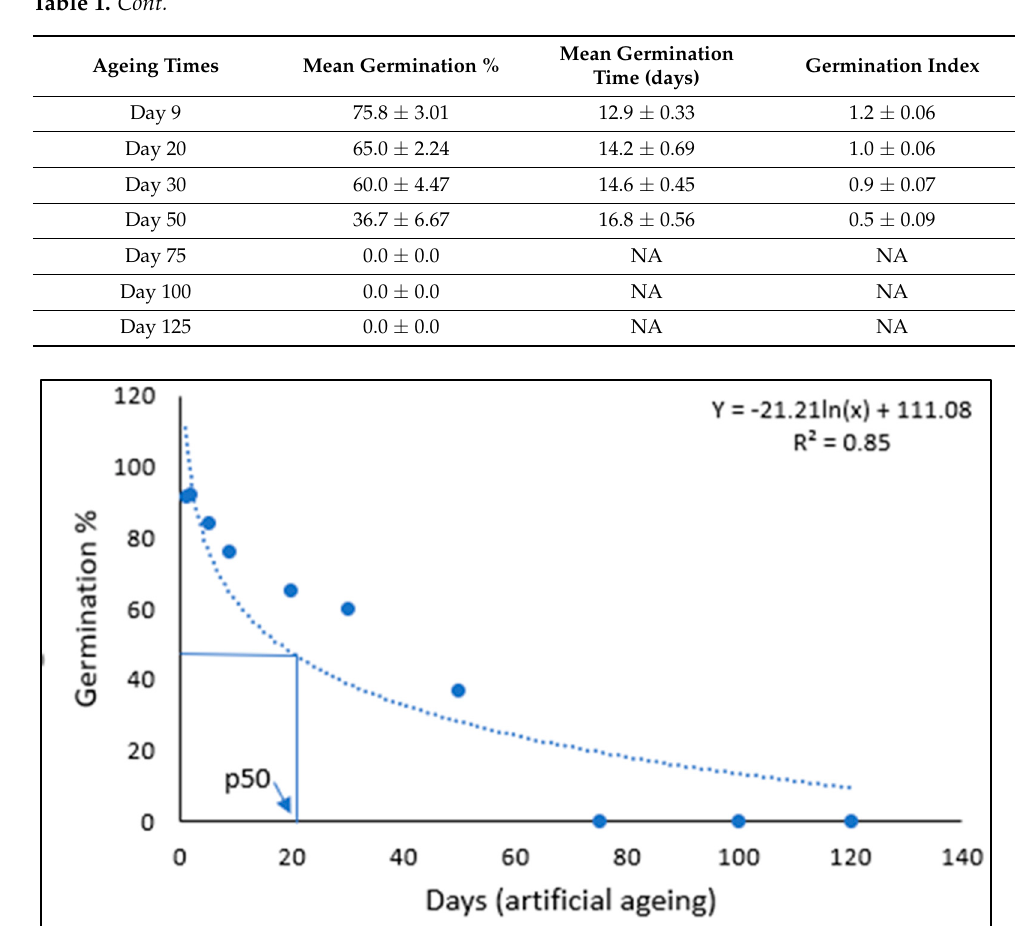
Figure 1. Logistic regression analysis of artificial ageing of Navua sedge seeds showing the time taken for seed viability to fall to 50% (P 50 ) value.